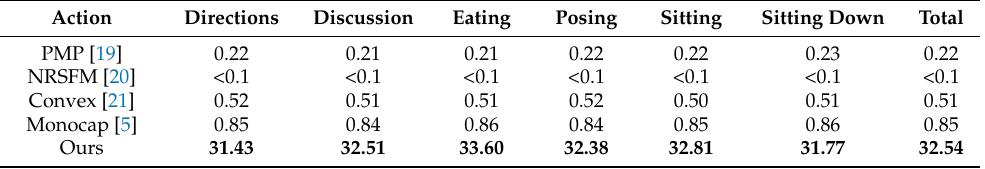
Table 7. Running speed of various algorithms (FPS) (Bold indicates fastest). Action Directions Discussion